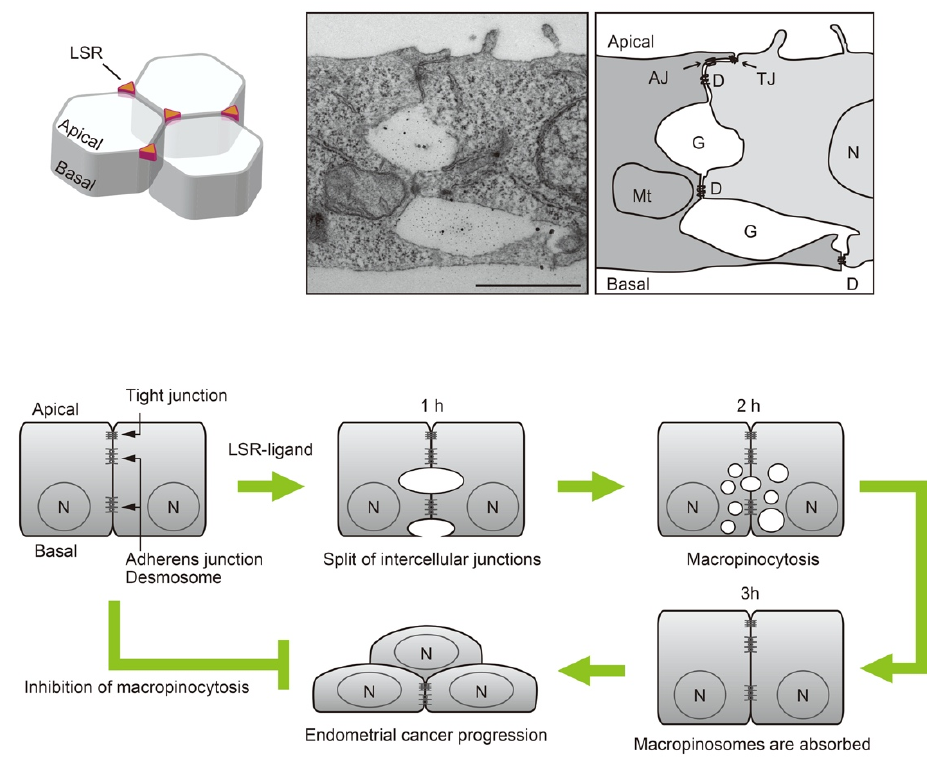
Figure 2. Schematic diagram of the LSR ligand-induced transient macropinocytosis derived from intercellular split. (Upper panels) In mature epithelial cells, LSR accumulates in apical tricellular junctions. Administration of the LSR ligand splits the adjacent intercellular spaces, leading to macropinocytosis. The intercellular adhesion apparatus was not disrupted by macropinocytosis. G, intercellular gap; TJ, tight junctions; AJ, adherens junctions; D, desmosomes; N, nucleus; Mt, mitochondria. Bar, 1 µ m. ( Lower panels ) The gap between adjacent cells expanded and filled with extracellular fluid, one hour after administration of the LSR ligand. Two hours after addition, numer- ous macropinosomes that incorporated the extracellular fluid appeared in the cytosol. The vesicles disappeared three hours after addition. The cells then initiated malignant cell growth, resulting in mul- tilayered cell growth. This pathway was suppressed in the presence of a macropinocytosis inhibitor.